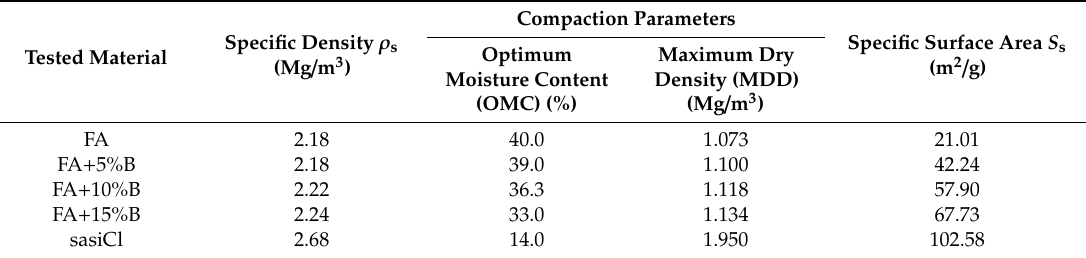
Table 2. Properties of tested